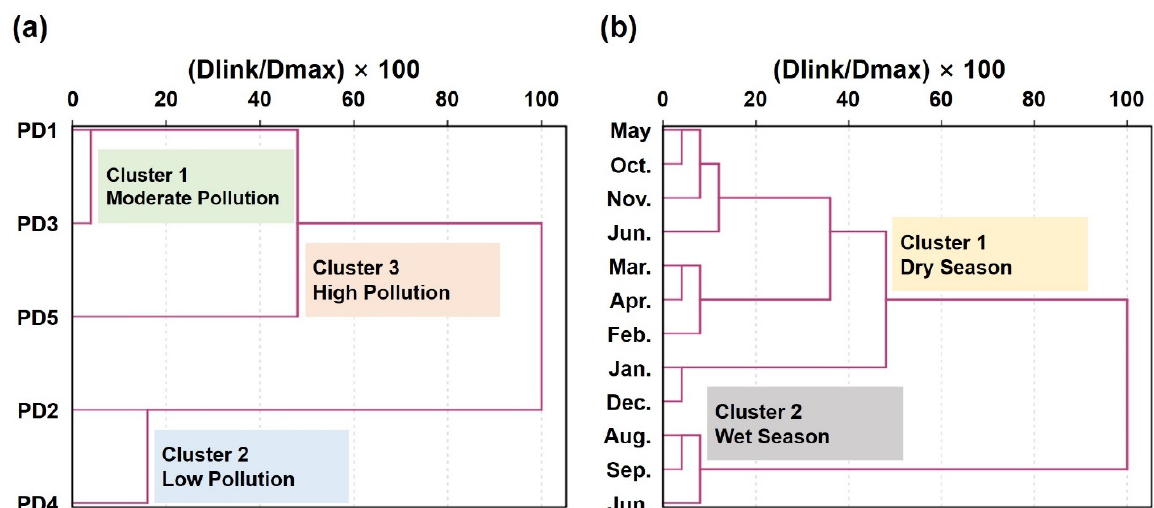
Figure 6. Dendrogram showing hierarchical clustering of ( a ) sampling sites; ( b ) seasons according to Ward’s method with squared Euclidean distance.